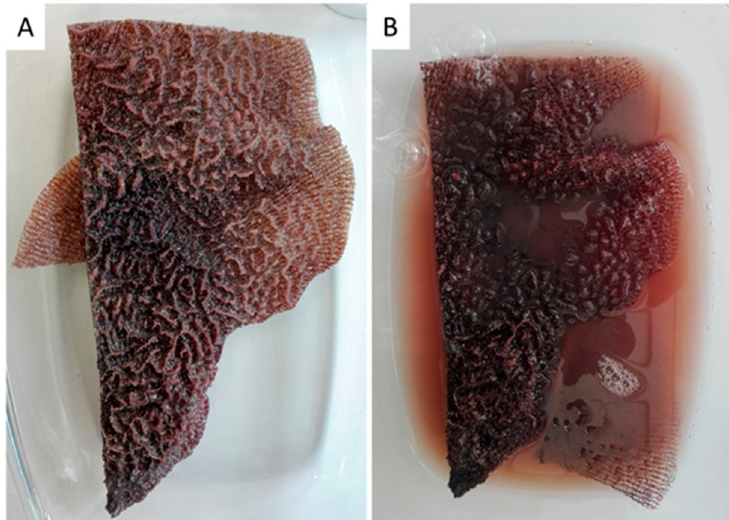
Figure 1. A fragment (20 × 10 cm) of the demosponge Ianthella labyrinthus after sampling ( A ) shows labyrinth-like surface morphology ( B ). It loses pigmentation immediately after placement into distillated water due to osmotic shock.